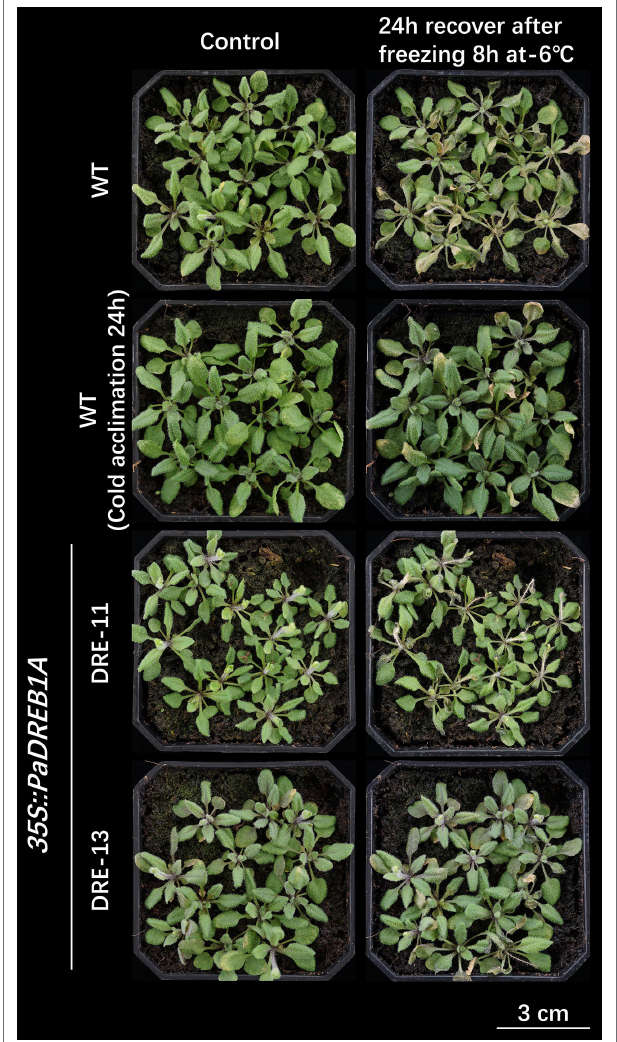
FIGURE 5 | Cold stress analysis of PaDREB1A transgenic lines and WT